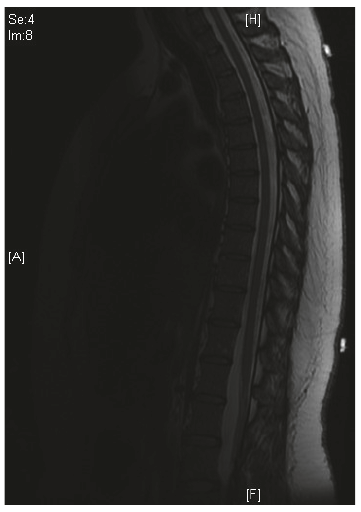
Figure 3: MRI at 6 weeks postpartum showing complete resolution of the spontaneous epidural